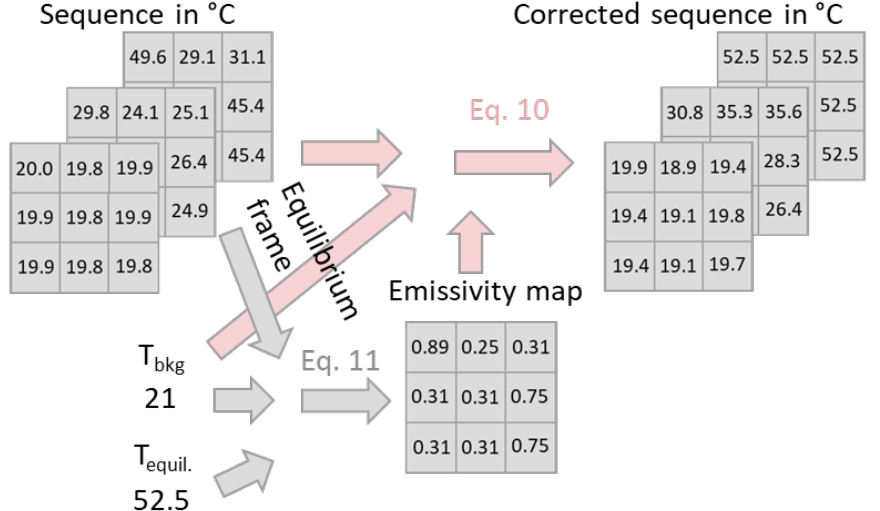
Figure 3. Scheme of method 2.